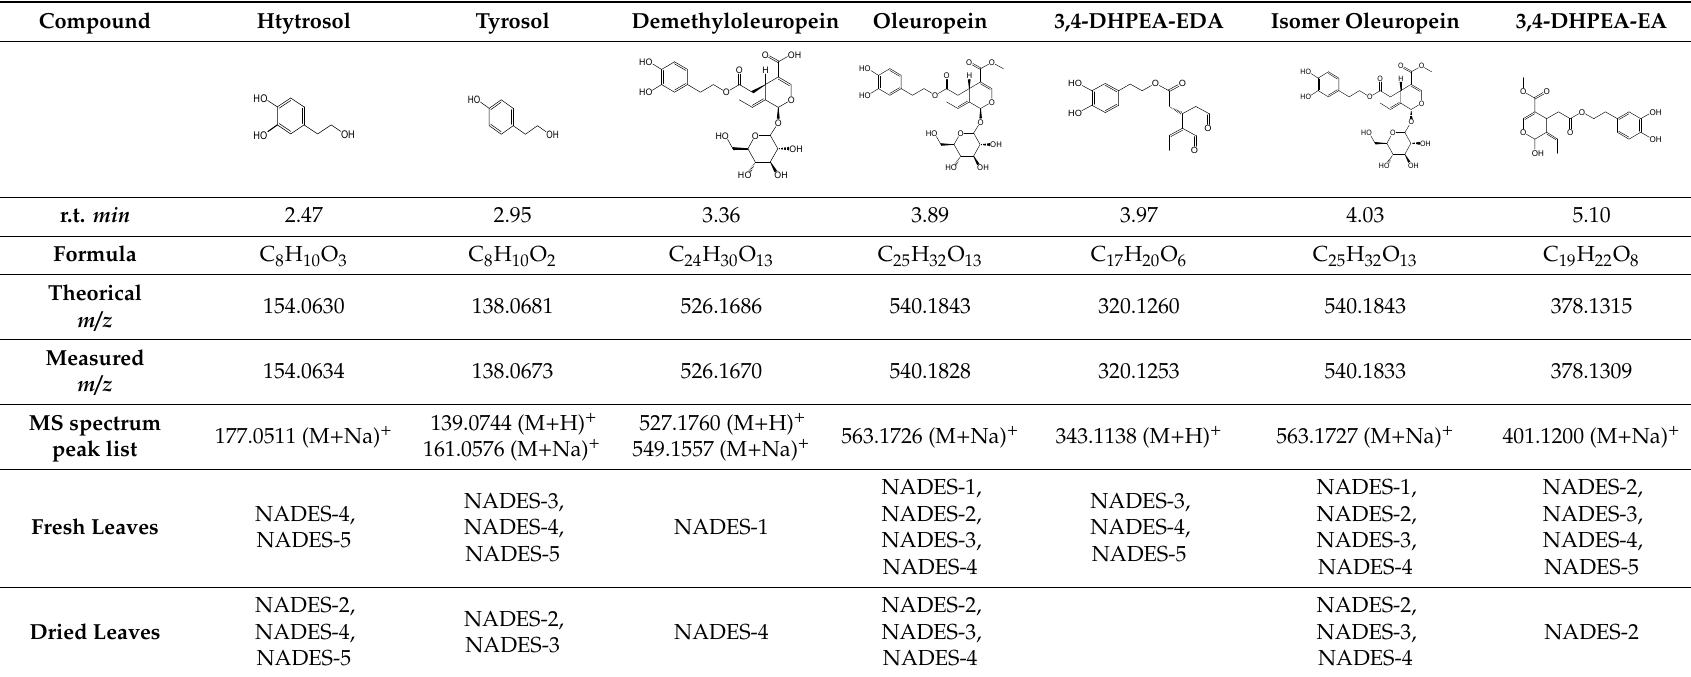
Table 2. Compounds identified by UPLC- ESI-QTOF-MS analysis in olive leaf extracts extracted with NADESs.